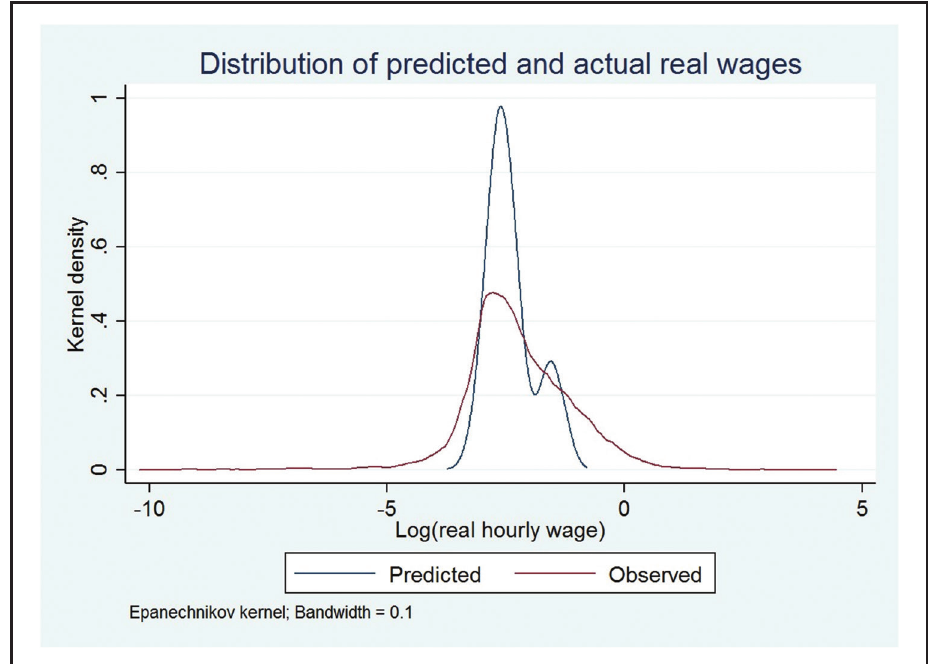
Figure 4 Kernel density plots of actual and predicted real wages of metropolitan out-migrants with